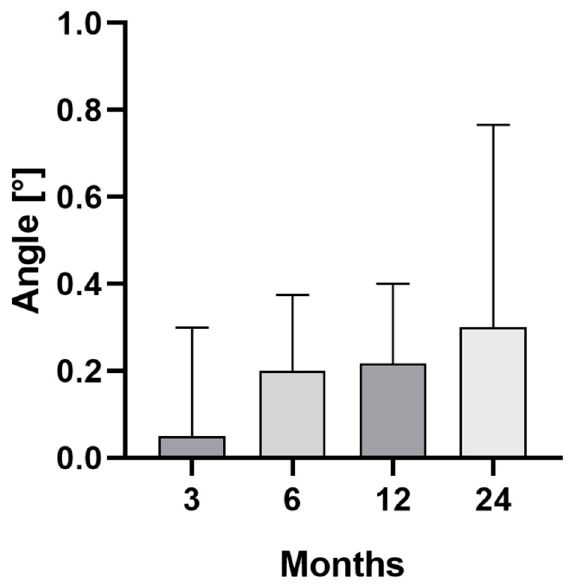
Figure 3. Median and interquartile range (bars) of the angle between stem and femur axis for the clinical follow-up of 24 months. clinical follow-up of 24